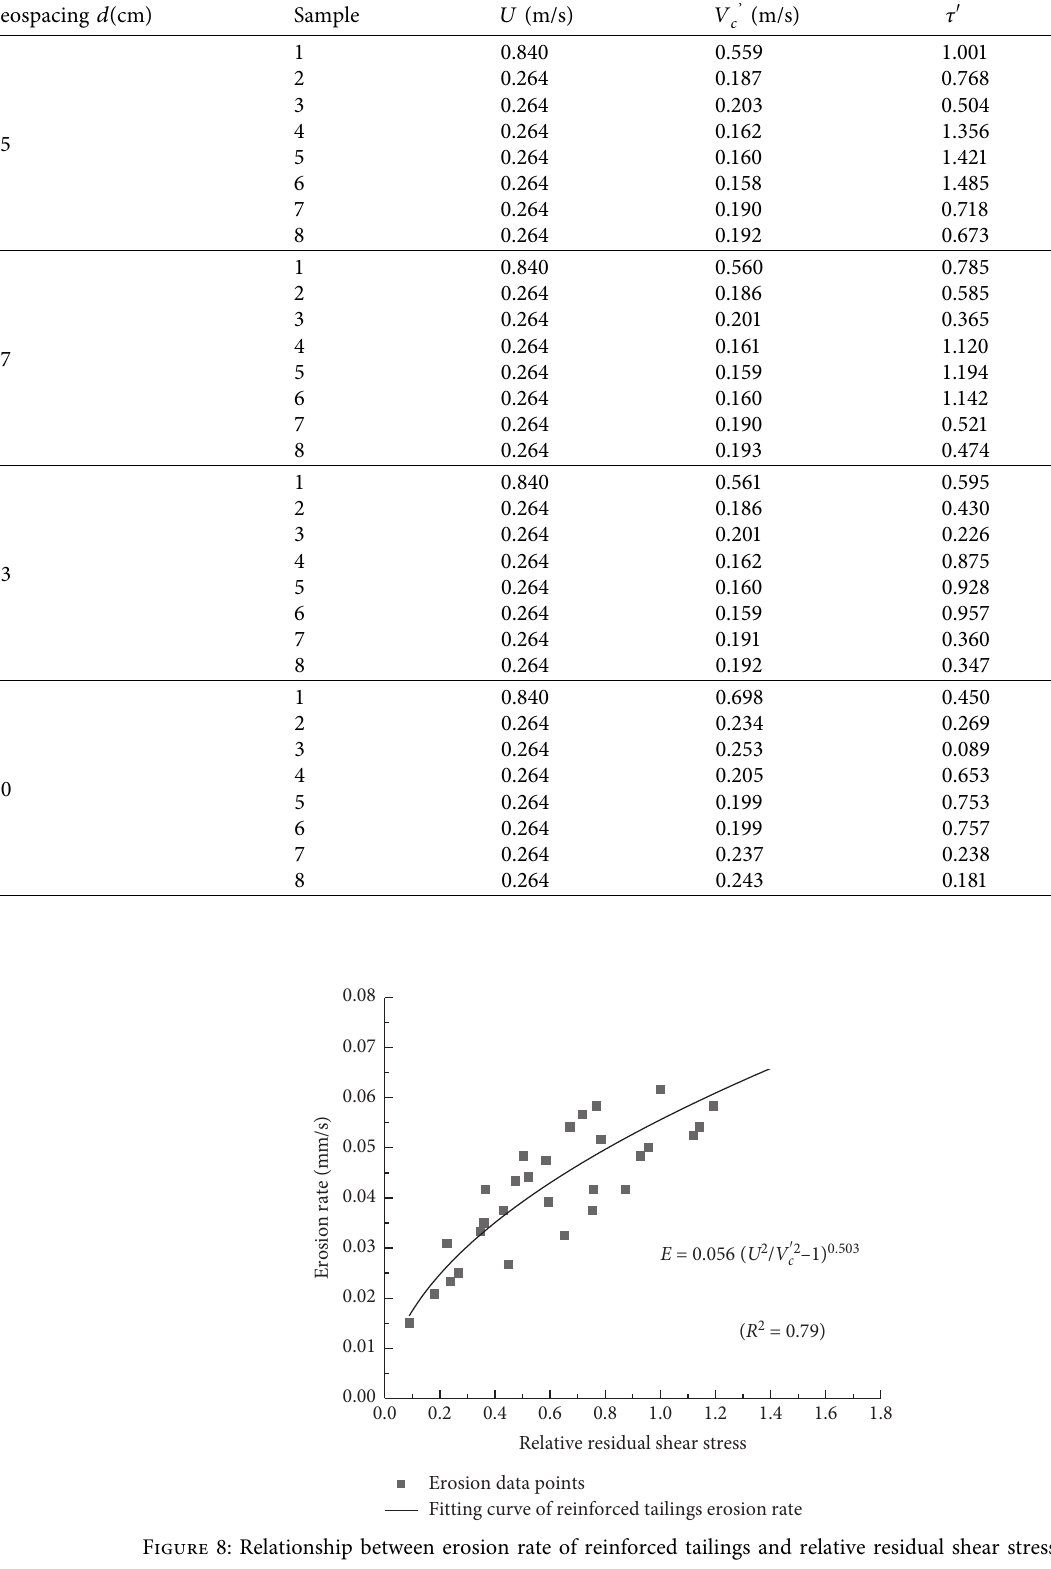
Table 6: Value of relative residual shear stress τ ’ and corrosion rate E of reinforced tailings.